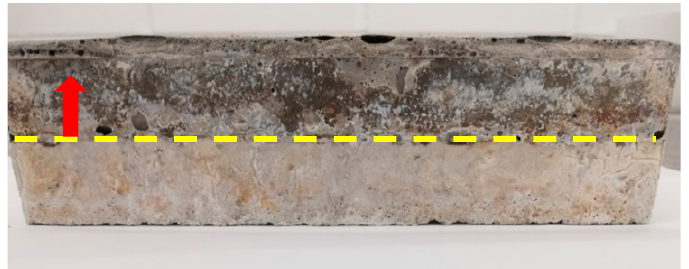
Figure 1. Separation of layers in the mix compositions with 25% foam content (without fibers).